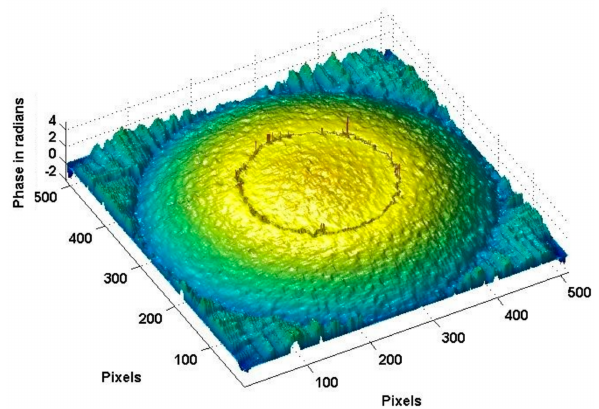
Figure 11. Phase image after